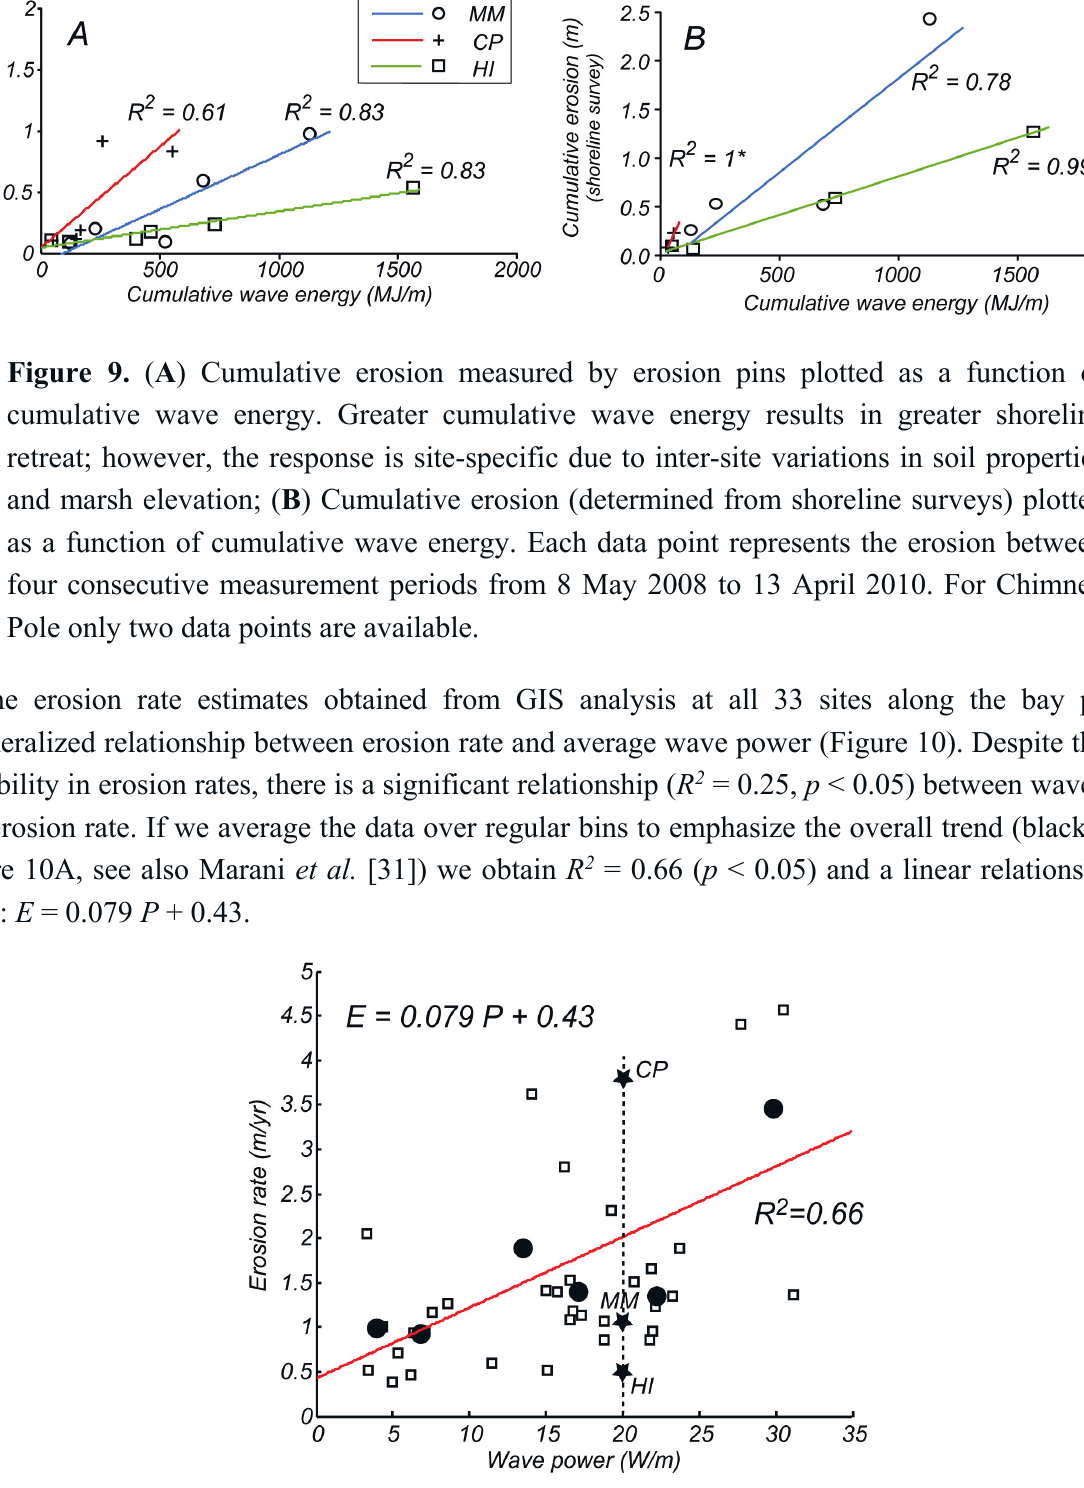
Figure 10. Marsh boundary erosion rate derived from GIS shoreline analysis (19 January 2002 to 30 June 2009) as a function of average wave power computed from the SWAN model at 33 sites. Solid black circles indicate values obtained by averaging data over regular “bins” to emphasize the overall trends ( R 2 = 0.66 with p < 0.05). The three stars represent the erosion data computed from the short-term field measurements with a wave power of 20